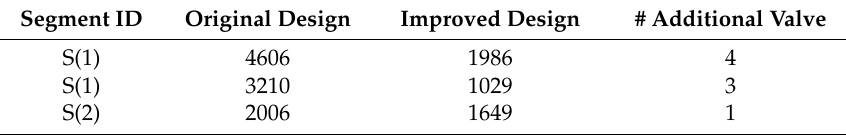
Table 12. Comparison number of affected water users in the reinforcement